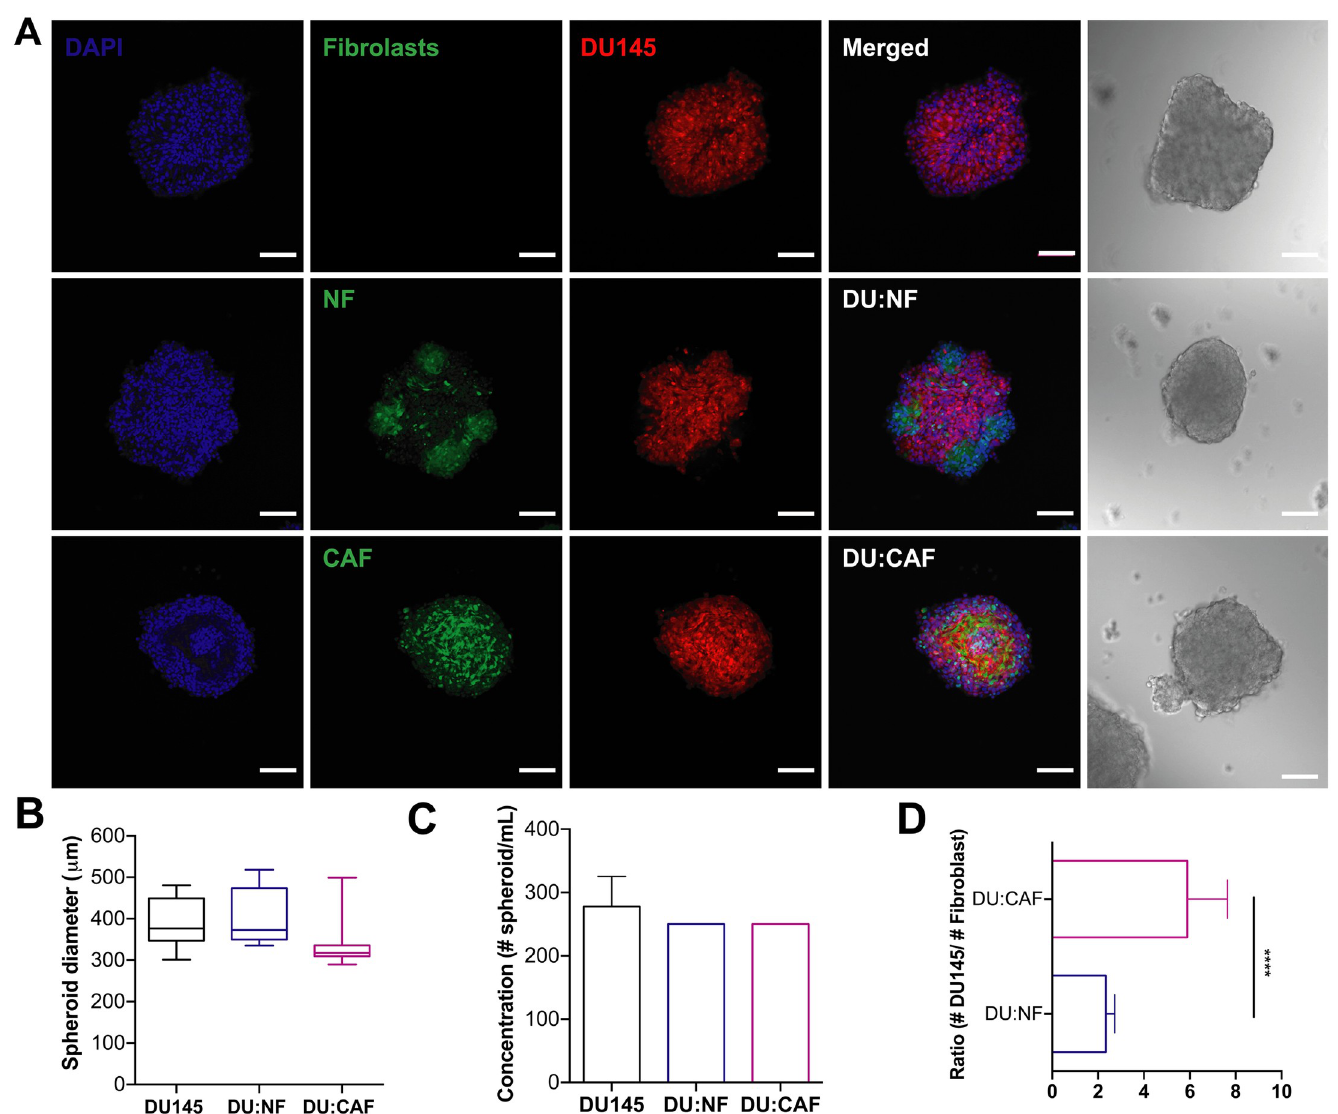
Fig 3. DU145 spheroids monocultured and co-cultured with prostate fibroblasts in AggreWell ™ 800 plates yielded consistent and reproducible spheroids. A . Brightfield image and confocal images of DU145 spheroids after 48 hr incubation. Scale bar = 100 μ m. B . Diameters of DU145, DU145-NF, and DU145-CAF spheroids. C . Concentration of spheroids/mL in DU145, DU145-NF, and DU145-CAF cultures. D . Ratio of DU145 cells to fibroblasts in cocultured spheroids. The values represent the mean ± SD (n = 3), ���� p < 0.0001.